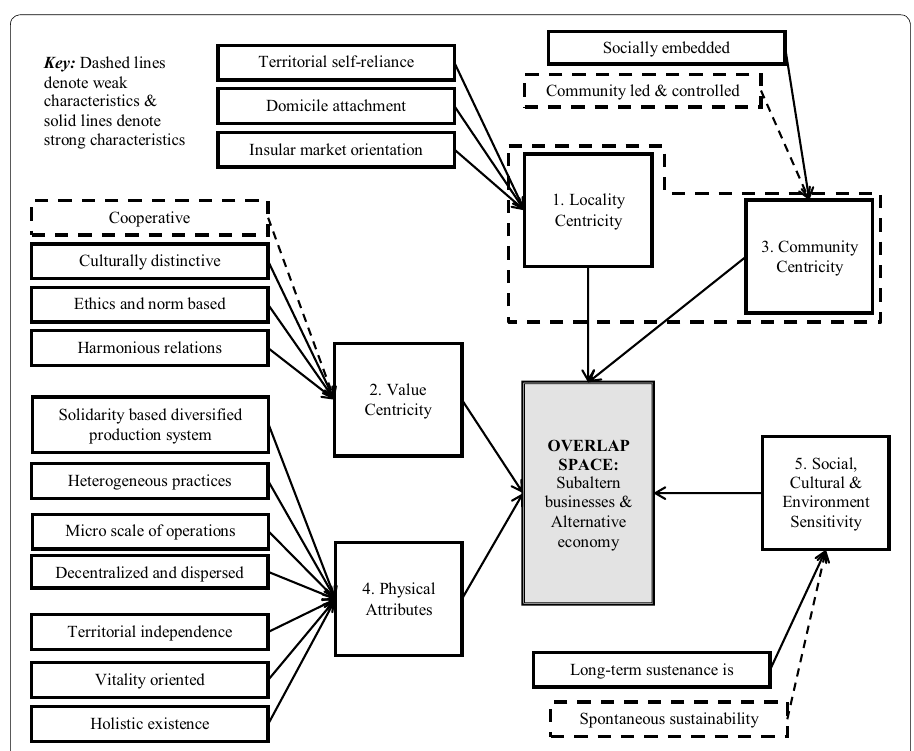
Fig. 3 Overlap space of subaltern businesses and alternative economy. Dashed lines denote weak characteristics and solid lines denote strong characteristics. Source : the figure is a result of the present